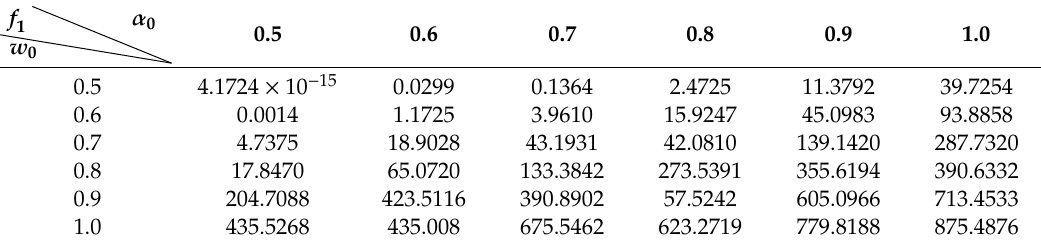
Table 3. The influence of w 0 and α 0 values on f 1 optimization results.